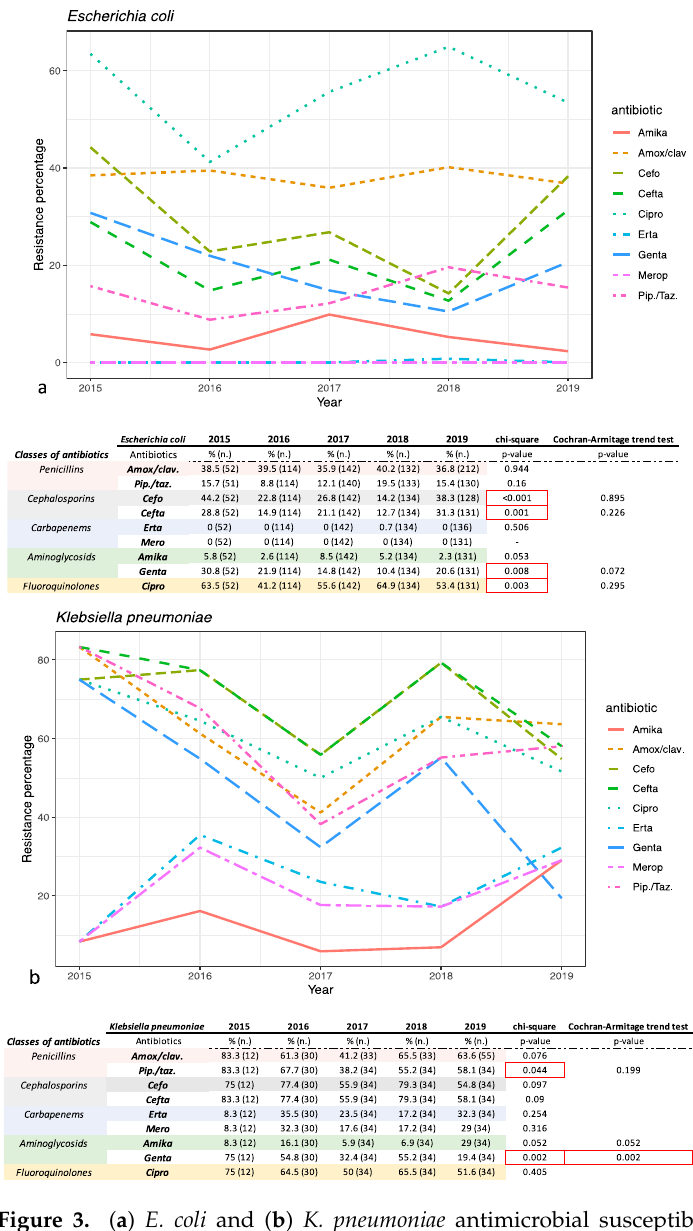
Figure 3. (a) E. coli and (b) K. pneumoniae antimicrobial susceptibility trend percentage is reported for each year investigated in the study. The table under the image reports the relative resistance percentage analyzed in the chart, divided by classes of antibiotics tested. % = % of resistance for each year; n .= number of total assays conducted for each year. Abbreviations: Amox./clav. = amoxicillin/clavulanic acid; Pip./Taz. = Piperacillin/tazobactam; Cefo. = Cefotaxime; Cefta. = Ceftazidime; Erta. = Ertapenem; Merop. = Meropenem; Amika.= amikacina; Genta. = Gentamicin; Cipro.= ciprofloxacin.